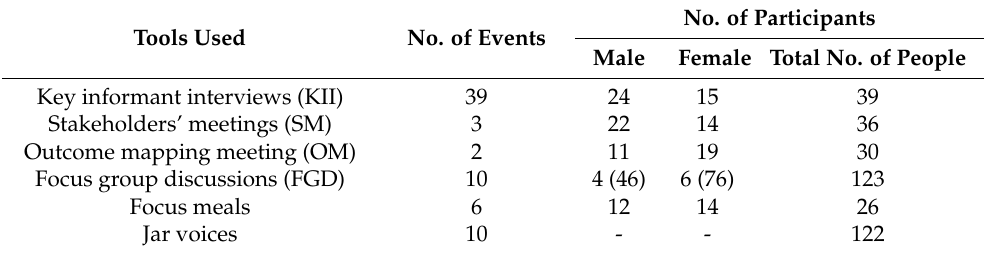
Table 1. Tools used for data